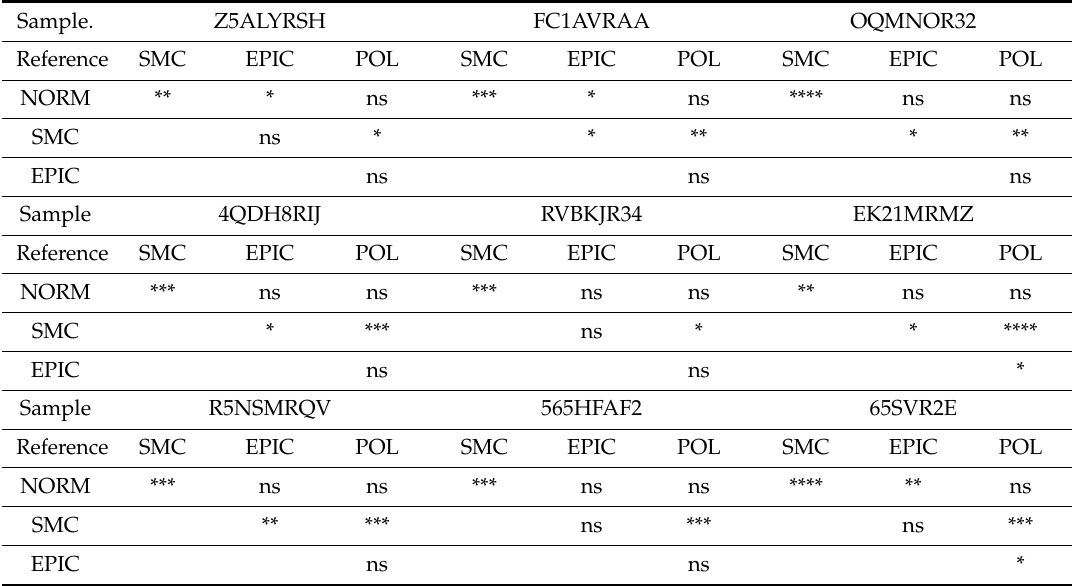
Table 2. Summary of the statistical analysis conducted on the molecular signatures after single normalization. Each individual signature obtained after single normalization was compared as matched data. The two by two comparisons showed non-significant variations (ns), or significant variations (* p < 0.05; ** p < 0.01; *** p < 0.001; Mann-Whitney test) demonstrating the importance of the normalization in getting relevant and consistent expression data. NORM = whole normal colon; SMC = smooth muscle cells; EPIC = colon epithelial cells; POL = precancerous